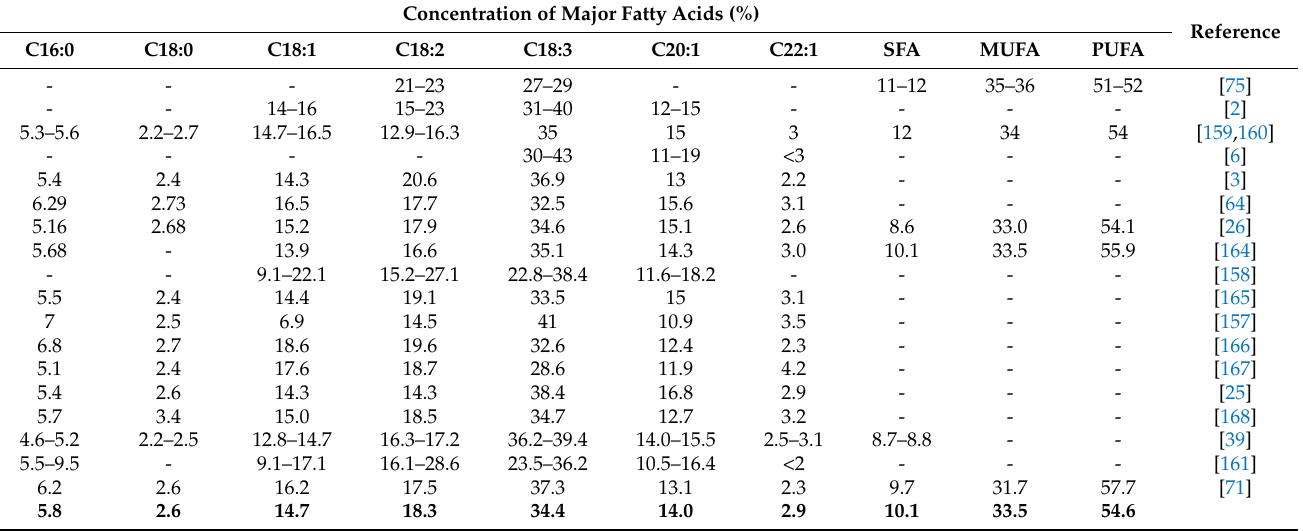
Table 2. Fatty acid profiles of C. sativa seed oil reported by various researchers. Bold font (bottom row) indicates mean values of fatty acid profile in C. sativa from the different reports. Dashes indicate missing